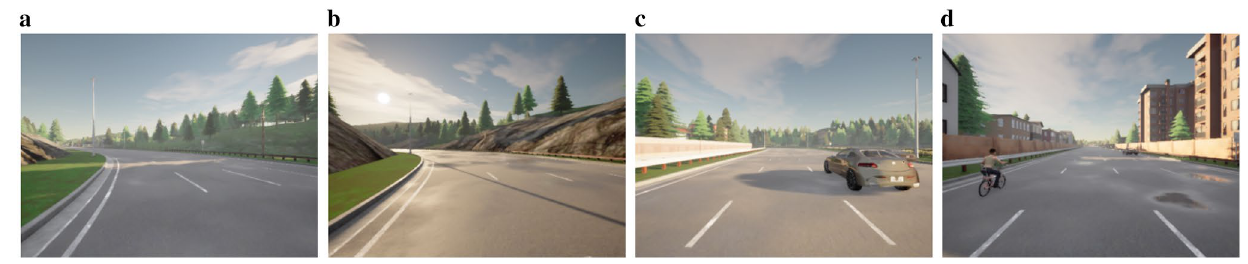
Fig. 3 An example of the images generated with CARLA: a , b normal images, c anomalous image with a car, d anomalous image with a bicy- cle and a